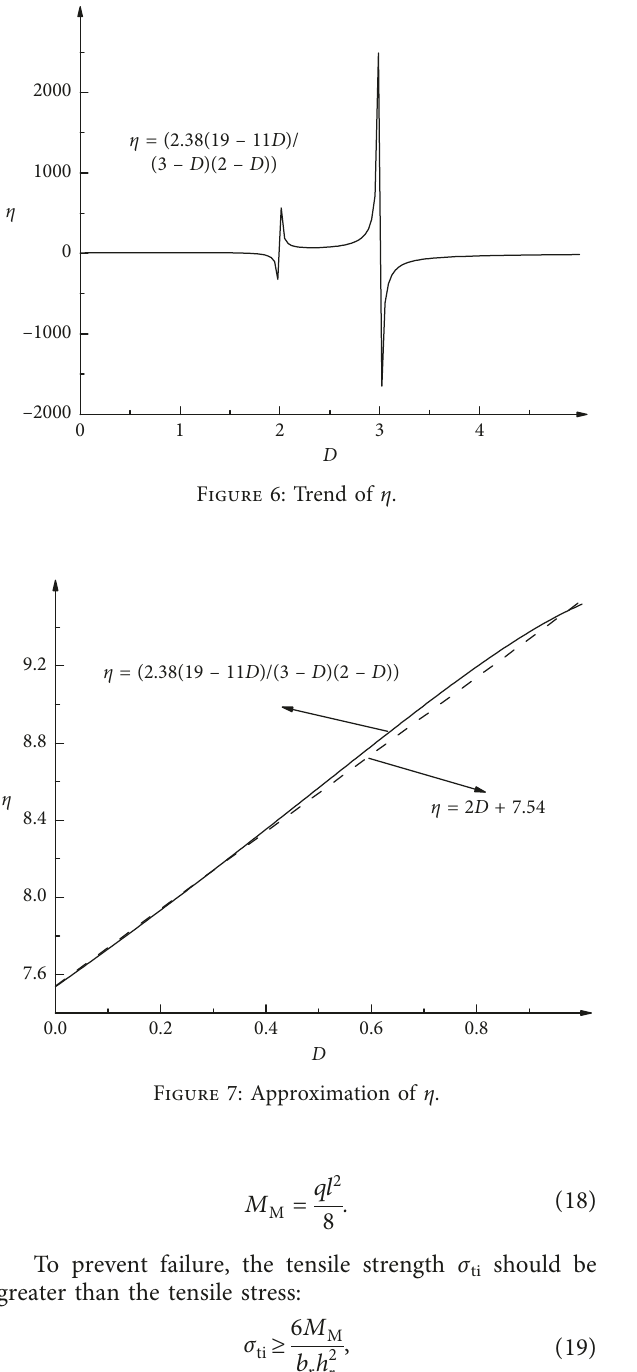
Figure 9: Trend of ψ .